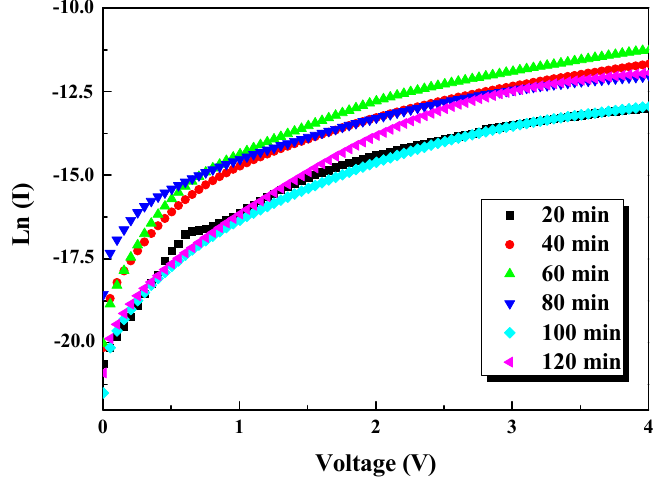
Figure 12. Logarithm of forward current versus voltage (Ln (I) vs. V) curves of SiNWs synthesized at different etching times.